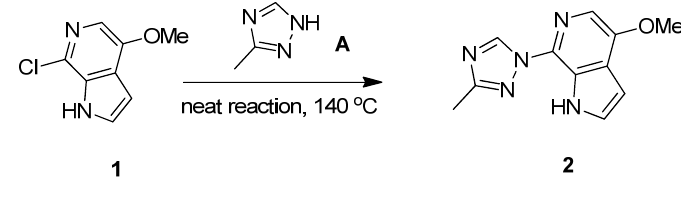
Table 2. Metabolic stabilities of control and test compounds in a human liver microsome assay. Predictive PK parameters were derived as outlined in Materials and Methods.